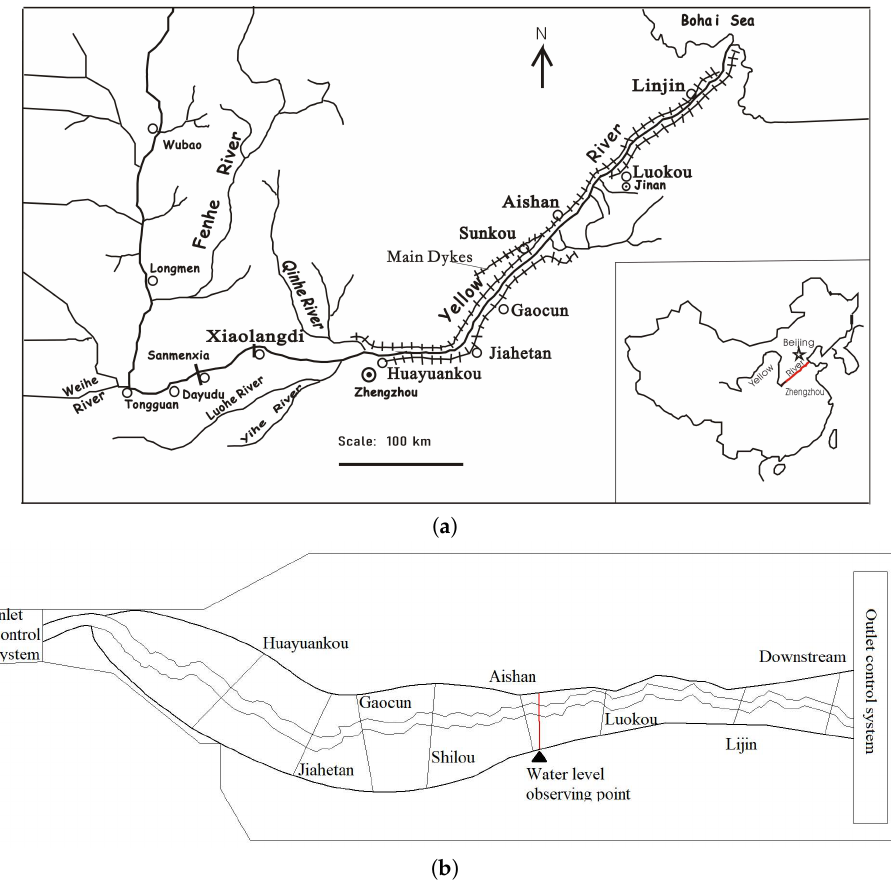
Figure 1. Map of the Lower Yellow River (LYR): ( a ) the location of the LYR; and ( b ) plan view of the micro-model in the